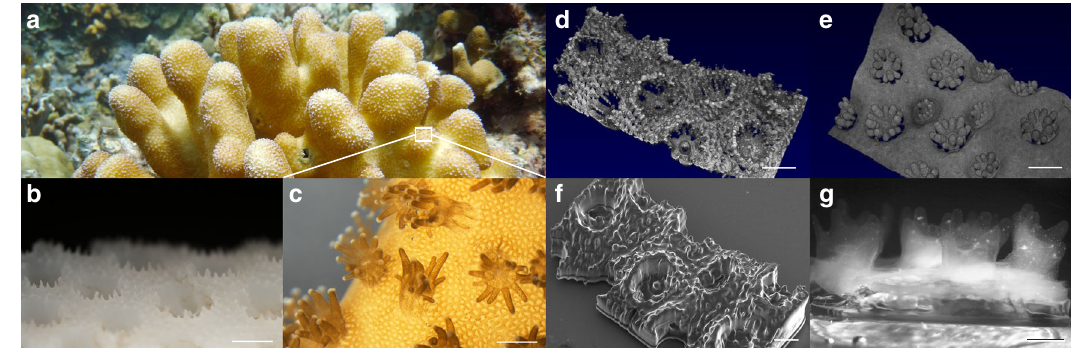
Fig. 1 Structure of natural and 3D printed bionic corals. Colony of the coral Stylophora pistilla growing at about 10 m depth on Watakobi Reef, East Sulawesi, Indonesia ( a ). Close-up photograph ( b, c ) and optical coherence tomography scanning ( d, e ) of coral skeleton and coral tissue, respectively. Scanning electron microscopy image of successful 3D printed skeleton replica showing corallites in 1:1 scale relative to the original design ( f ). Photograph of living bionic coral growing Symbiodinium sp . microalgae ( g ). The living tissue was printed on top of the skeleton mimic and the bionic coral was cultured for 7 days. Scale bar = 1 mm ( b – f ) and 750 µ m ( g